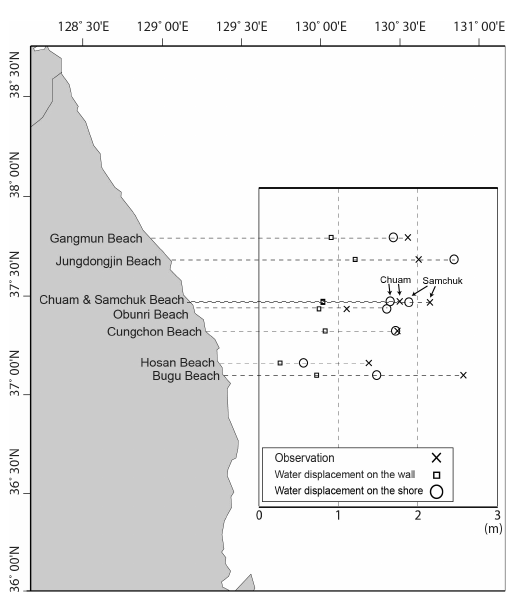
Fig. 6. Comparison of the computed and observed runup heights on the eastern Korean coast. Hokkaido-Nansei-Oki earthquake 13:17 UTC on 12 July 1993. The epicentre of this earth- quake was in the East (Japan) Sea at 42.8 ◦ N, 139.2 ◦ E, about 15–30 km off the small offshore island of Okushiri along the west coast of Hokkaido (Fig. 3). The magnitude of the earthquake was 7.8. Over 230 people were killed, and a majority of deaths were caused by the